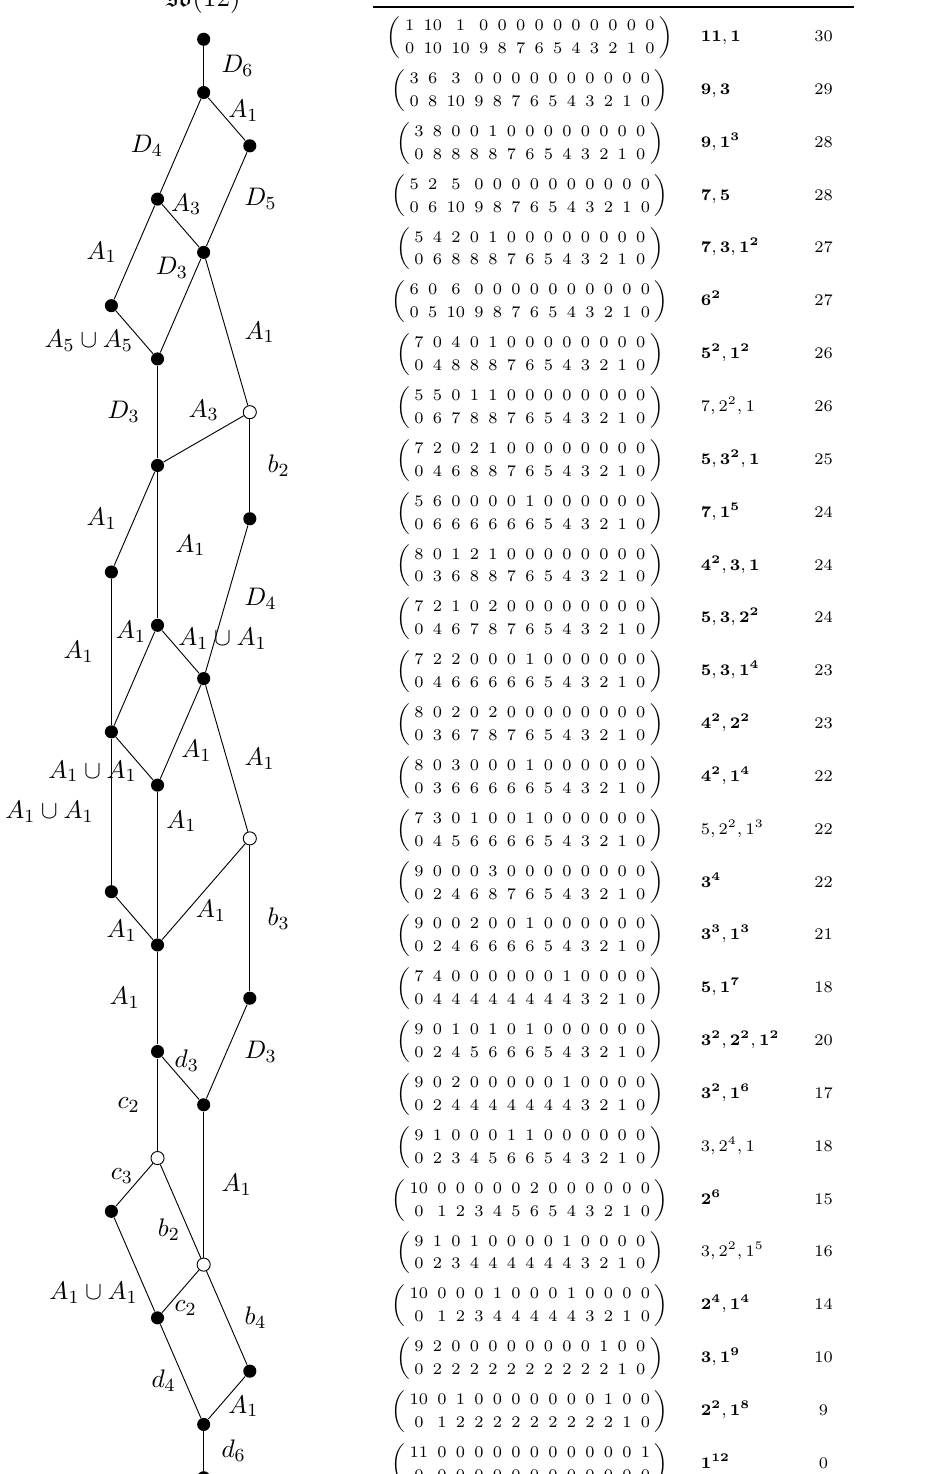
Table 19. Results obtained applying the matrix formalism to so